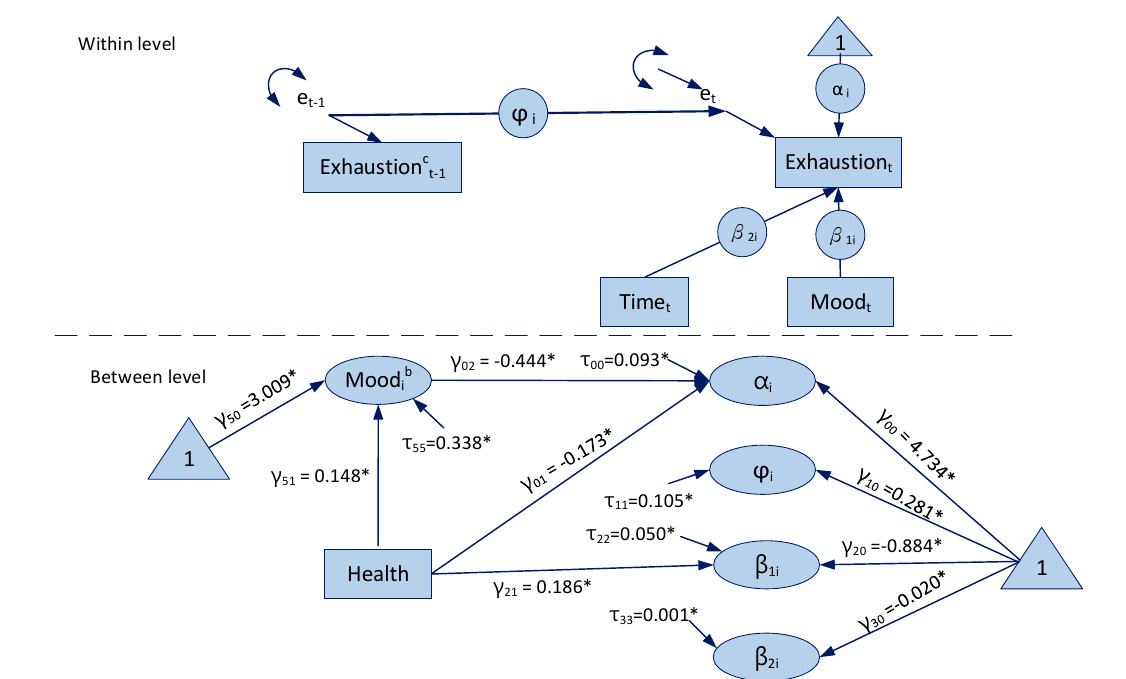
Figure 1. Path diagram and estimated parameters of the study model. * p < 0.05.